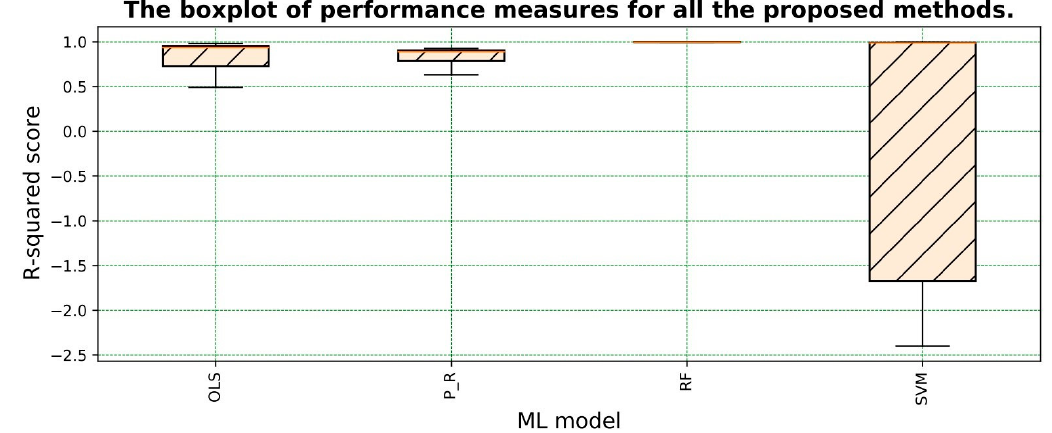
Figure 5. Boxplot of the performance measures for the proposed ML techniques.